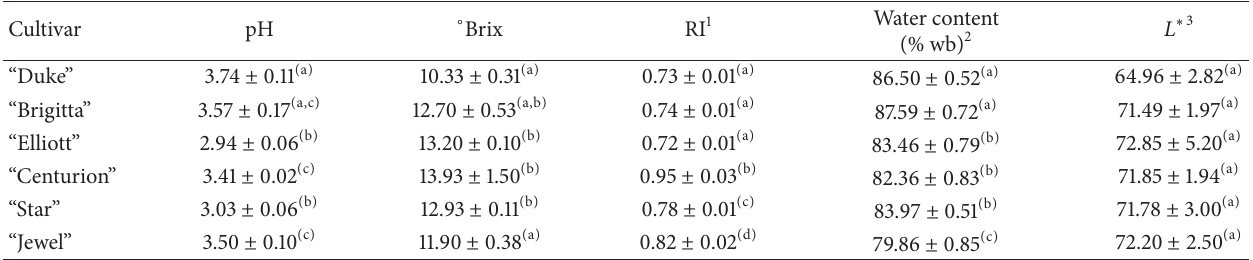
Figure 3: pH and ∘ Brix variations of different cultivars for different storage times at 4 ∘ C and 90% RH. Table 1: Quality parameter differences between fresh cultivars.